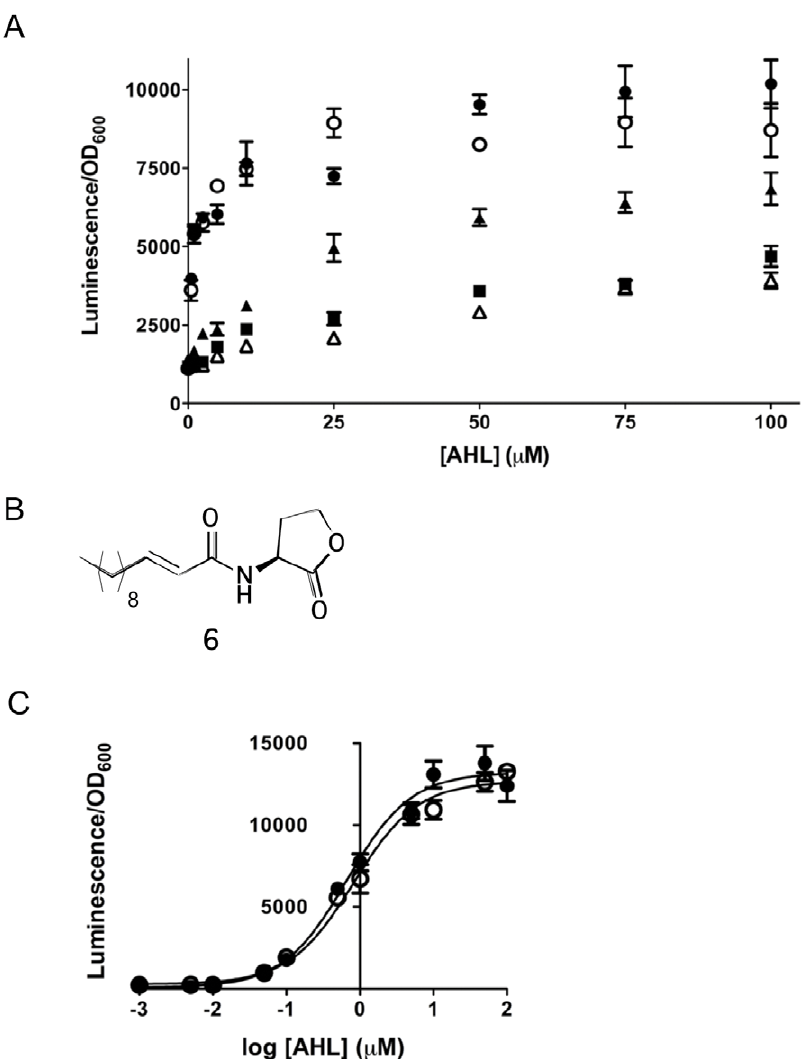
Figure 3. Autoinducer activities of AHL derivatives in an abaI :: lacZ mutant A.baumannii strain. Values shown are relative luminescence units normalized with respect to cell viability (OD 600 ). A, Autoinducer activities from 0–100 m M. Closed circle = 3a . Open circle = 3b . Closed triangle = 1 . Square = 6 . Open triangle = 3-oxo-C 12 - D -HSL. B, Structure of N -(3-dodecenoyl)- L -homoserine lactone ( 6 ). C, Enhanced view of autoinducer activity of 3a and 3b at lower concentrations. Closed circle = 3a . Open circle = 3b . EC 50 and p values determined using GraphPad Prism v5.0b for Mac OS X.